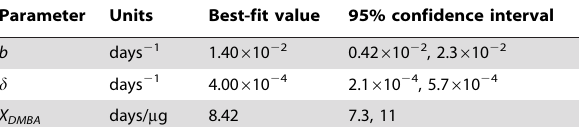
Table 1. Best-fit model parameters for the excess relative risk (ERR) of mammary tumors and dysplasias in mice treated with DMBA and/or irradiated with c -rays and neutrons at high or low dose rates.